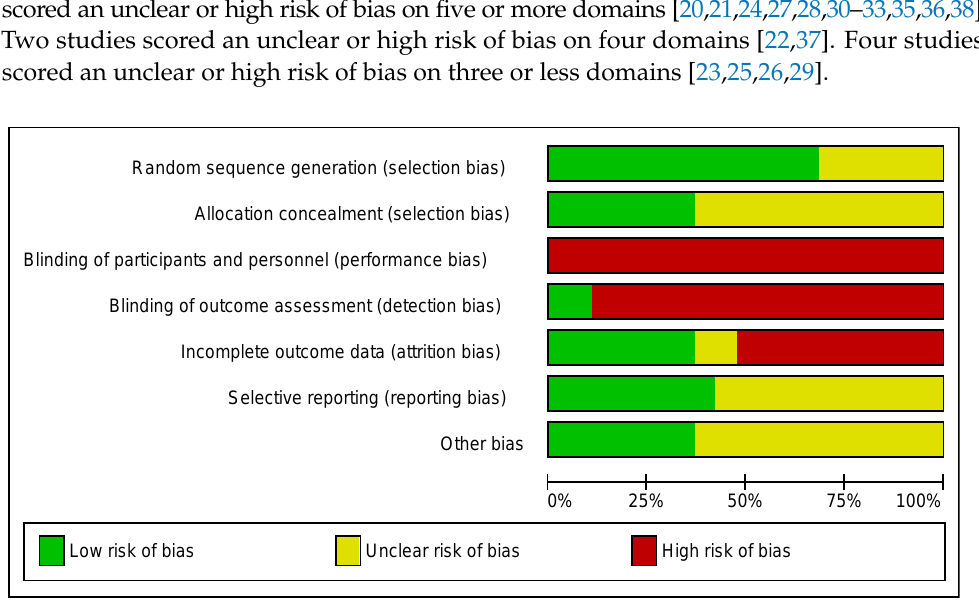
Figure 2. Risk of bias summary.